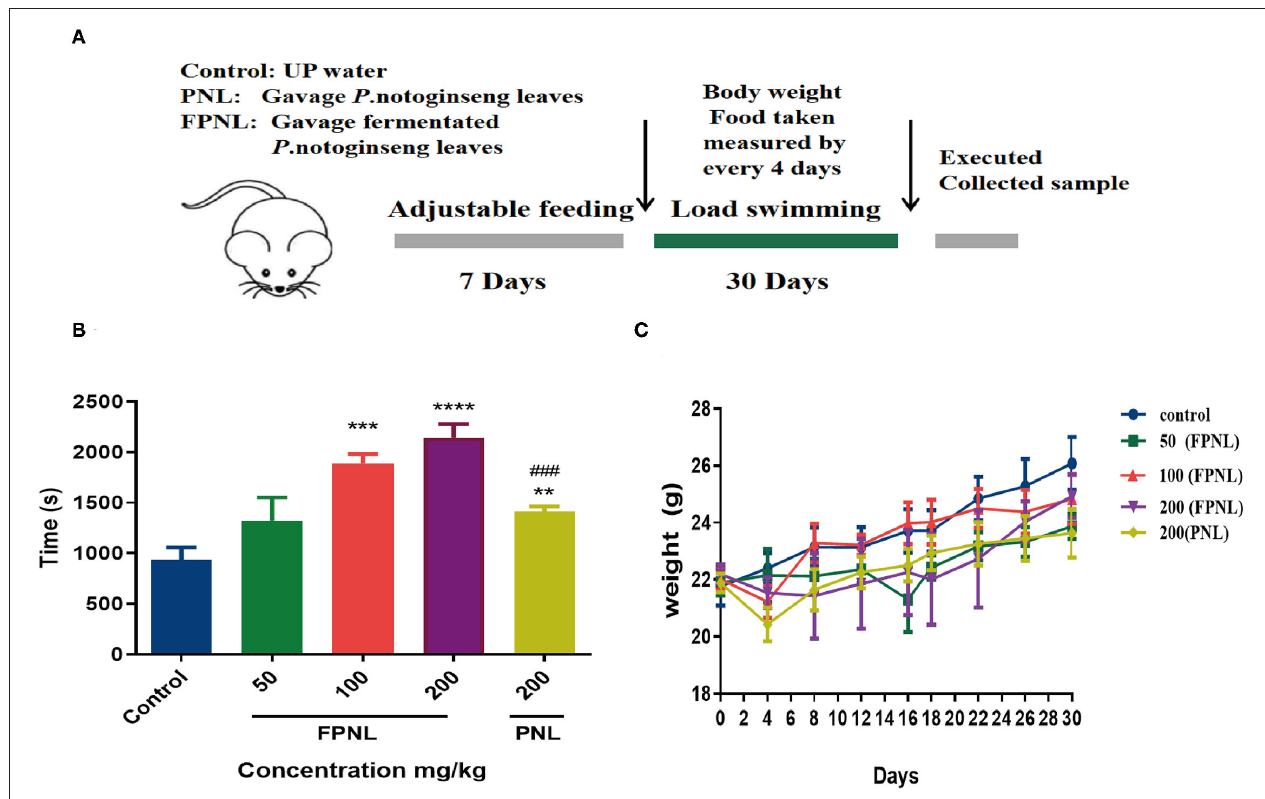
FIGURE 6 | Fermented P. notoginseng leaves alleviates fatigues in swimming mice. (A) Loading swimming experimental design. (B) Swimming time with weight loading after gavage PNL and FPNL. (C) Body weight, measured every 4 days. Data are expressed as mean ± SEM from six independent parallel experiments ( n =